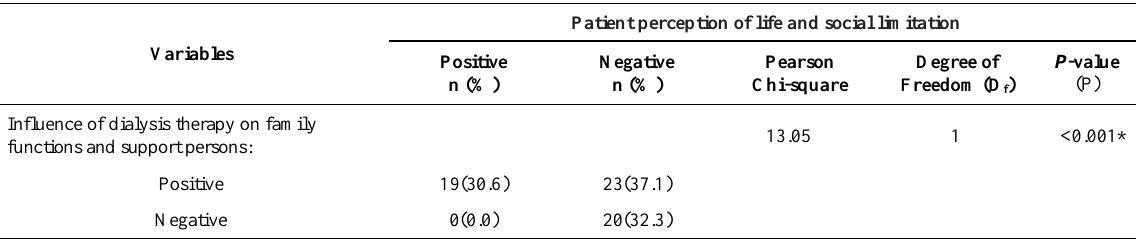
Table 4. Relationship between patient perception of life and social limitations and perceived influence of dialysis therapy